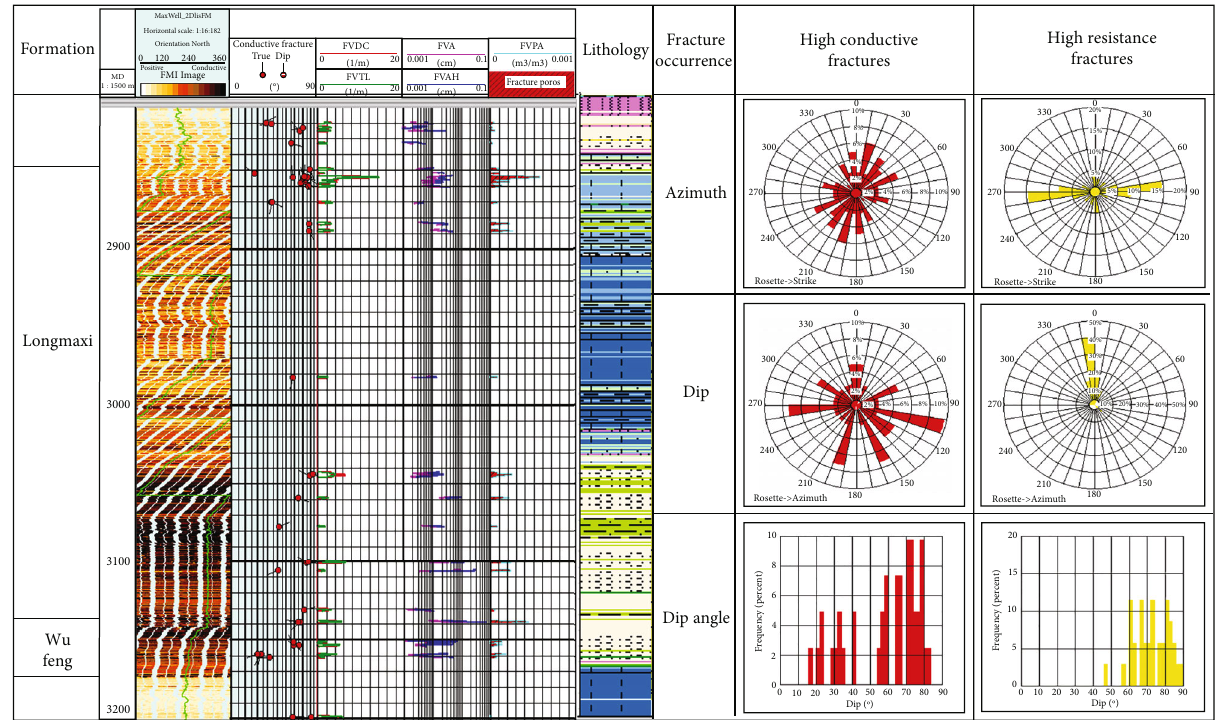
Figure 12: Fractures of Longmaxi Formation in FMI of Well